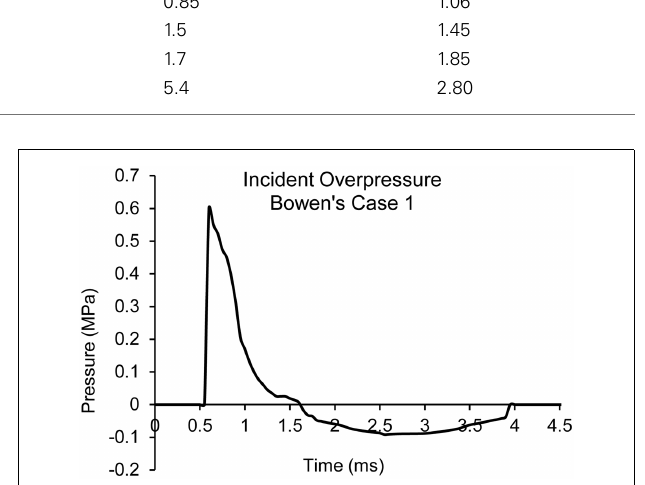
head model were subjected to sideways blast (lateral-to-lateral axis) (Case 5) and backwards (posterio-anterior axis) (Case